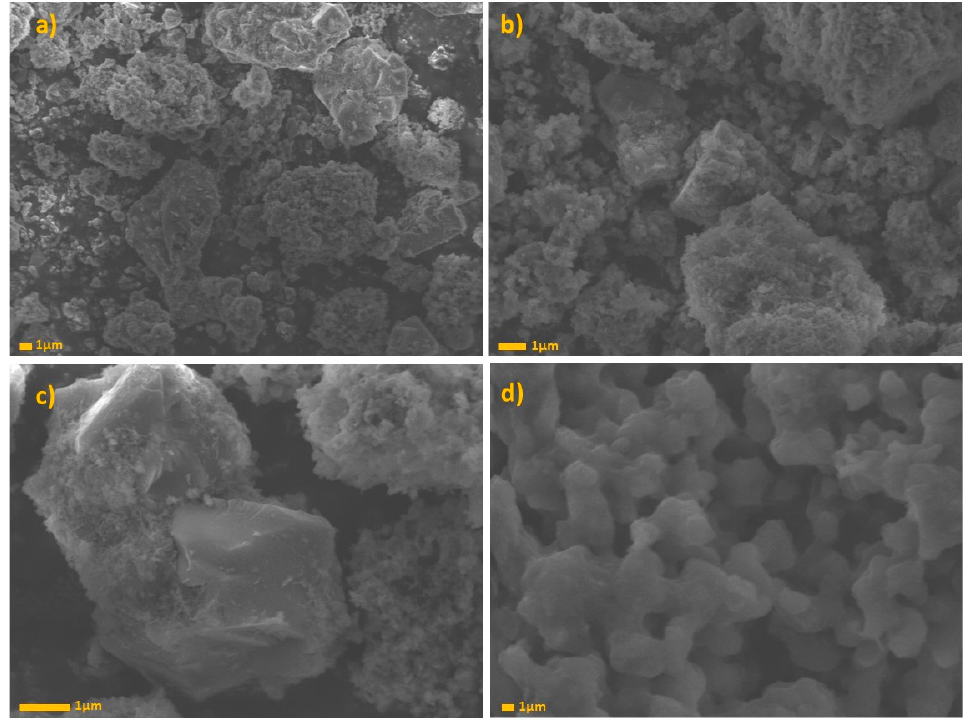
Figure 7. GS SEM images at ( a ) 3000 × , ( b ) 7000 × , ( c ) 13,000 × , and ( d ) 30,000 ×